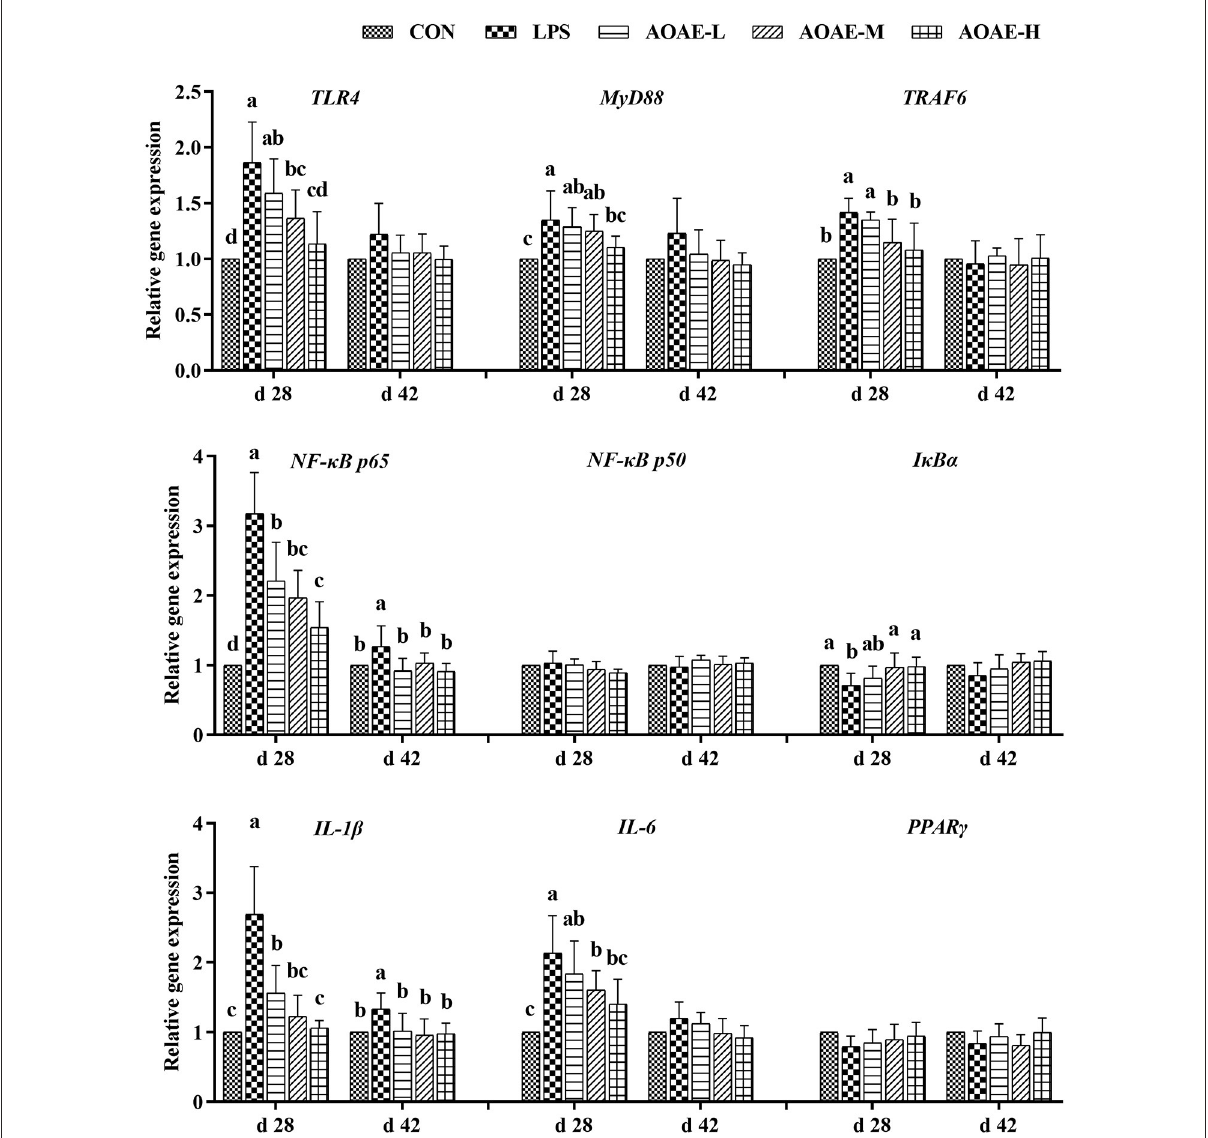
FIGURE2 Effect of AOAE on the expression of TLR4/NF- κ B pathway related genes in spleen of broilers challenged with LPS. (1) TLR4, toll like receptor 4; MyD88, myeloid differentiation factor 88; TRAF6, tumor necrosis factor receptor associated factor 6; NF- κ B p65, nuclear factor kappa B p65; NF- κ B p50, nuclear factor kappa B p50; I κ B α , inhibitor of NF- κ B alpha; IL-1 β , interleukin 1 beta; IL-6, interleukin 6; PPAR γ , peroxisome proliferator-activated receptor γ . (2) AOAE, Artemisia ordosica alcohol extract; CON, non-challenged broilers fed a basal diet;